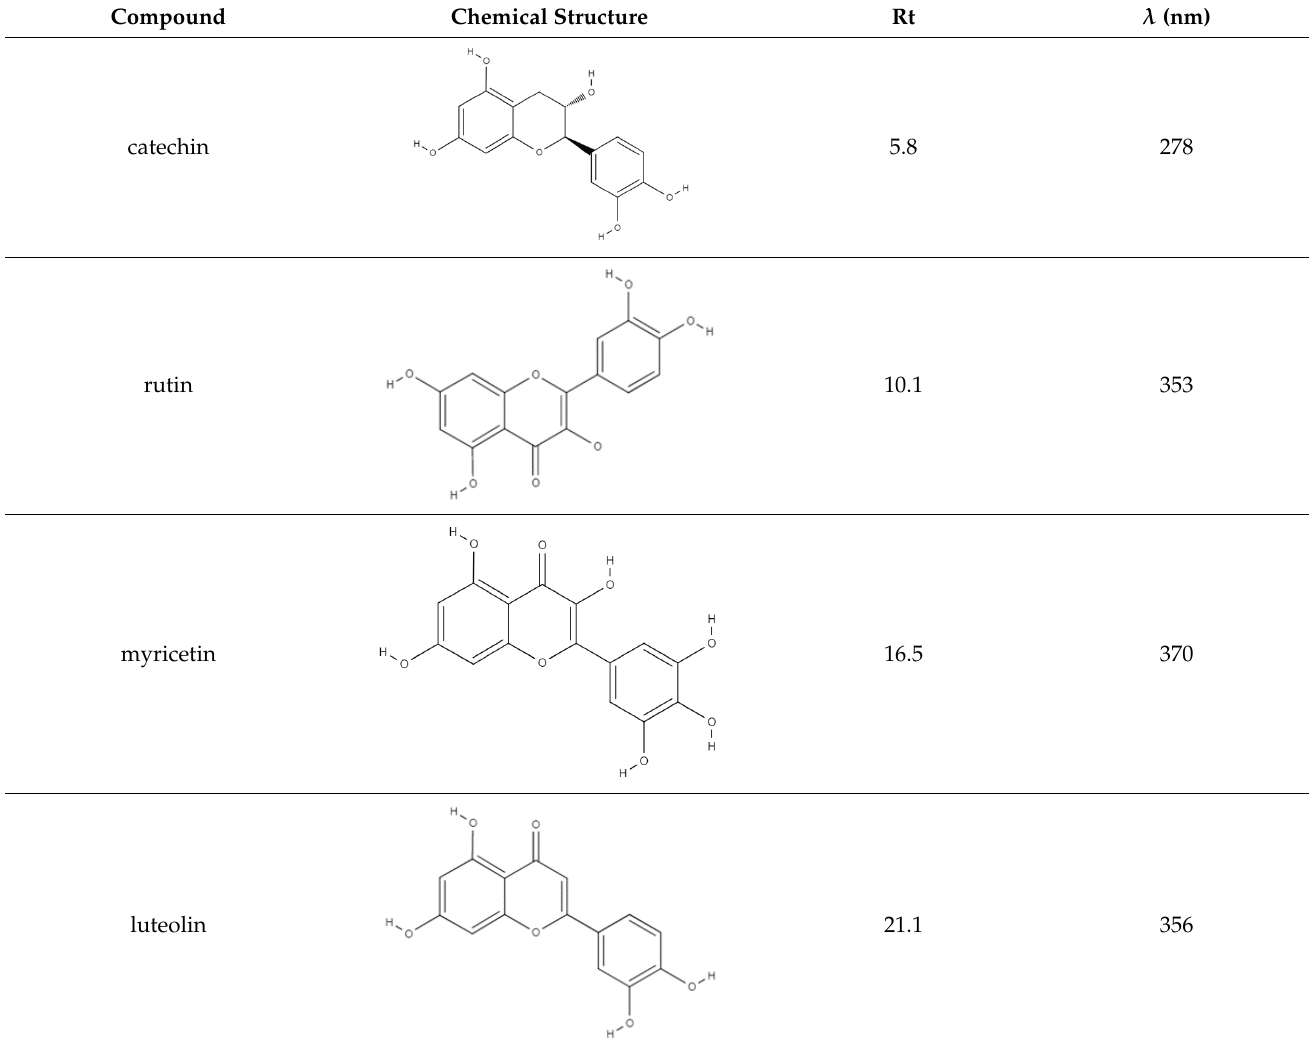
Table 4. Retention time and maximum absorption wavelength of the determined flavonoids. Compound